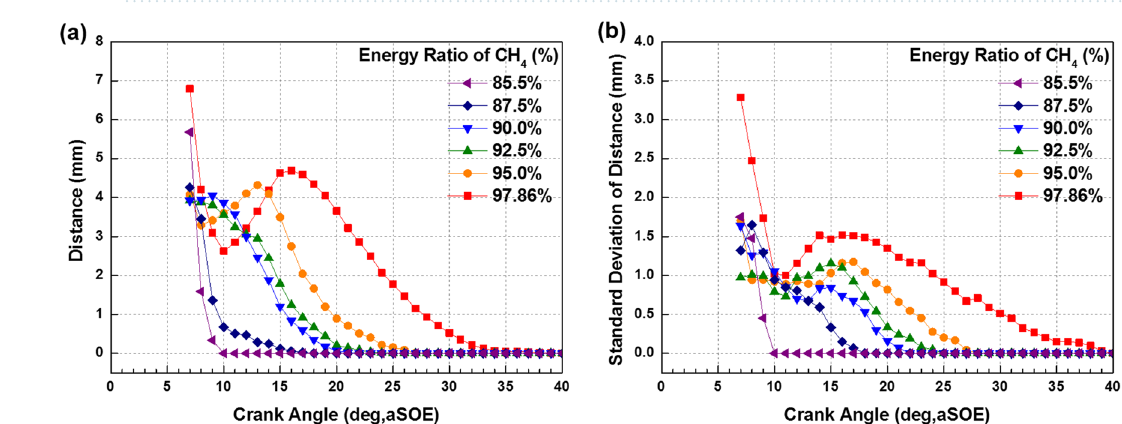
Figure 20. (a) Distance the center of between the combustion chamber and flame surfaces and (b)